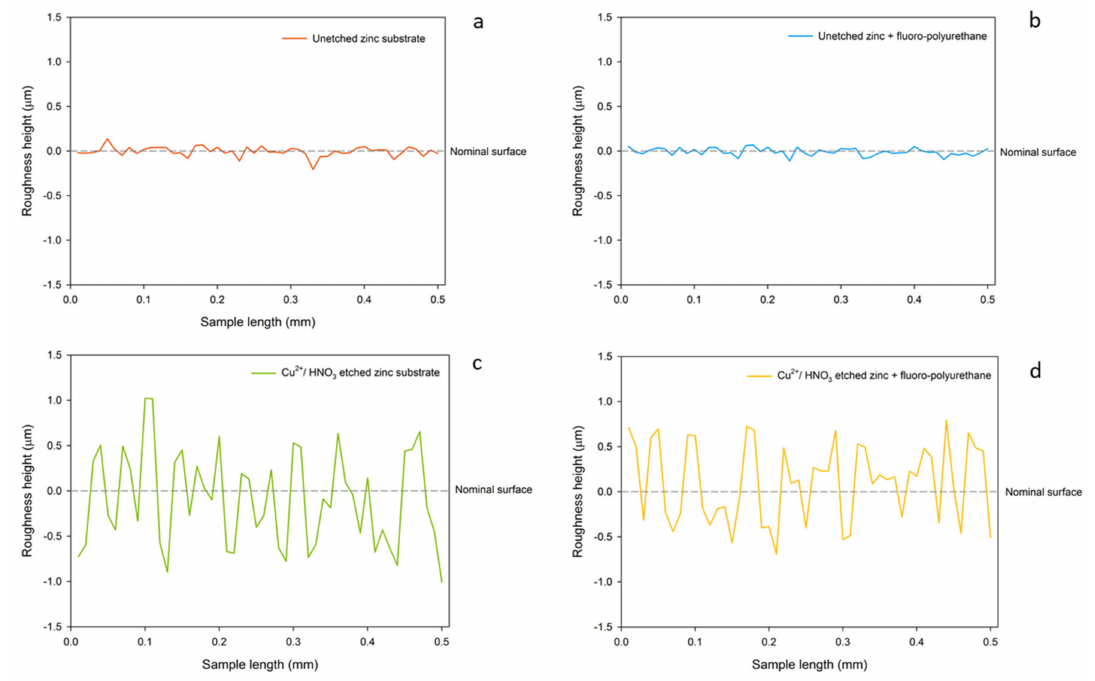
Figure 4. Surface profiling of ( a ) unetched zinc substrate, ( b ) unetched zinc + fluoropolyurethane, ( c ) Cu 2 + / HNO 3 -etched zinc, and ( d ) Cu 2 + / HNO 3 -etched zinc +